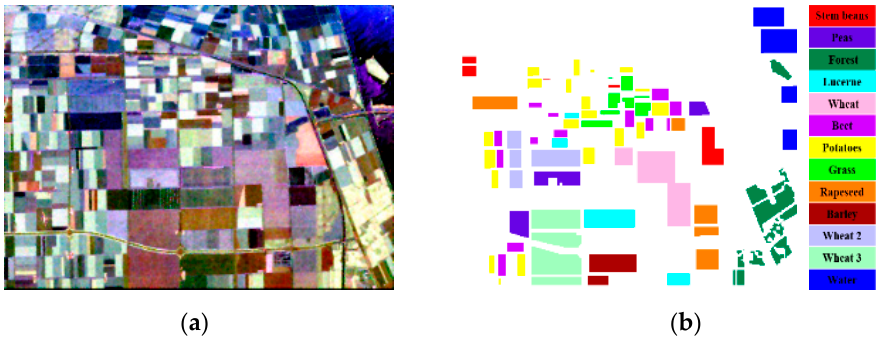
Figure 3. Original Flevoland dataset. ( a ) Pauli RGB image for the Flevoland dataset. ( b ) Ground truth and legend of ( a ).